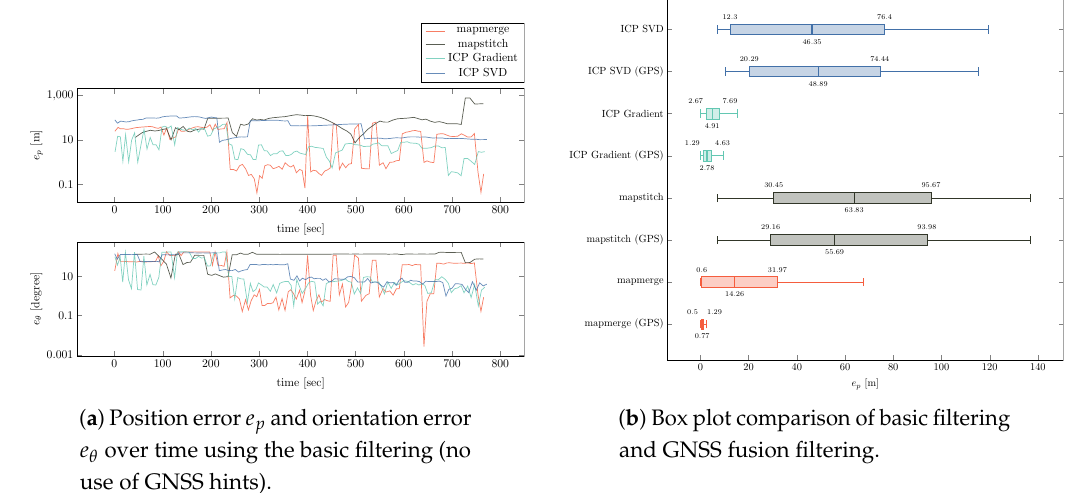
use of GNSS hints). Figure 10. Position and orientation error plots for a simulated flight in the 100 m × 100 m sized outdoor 1